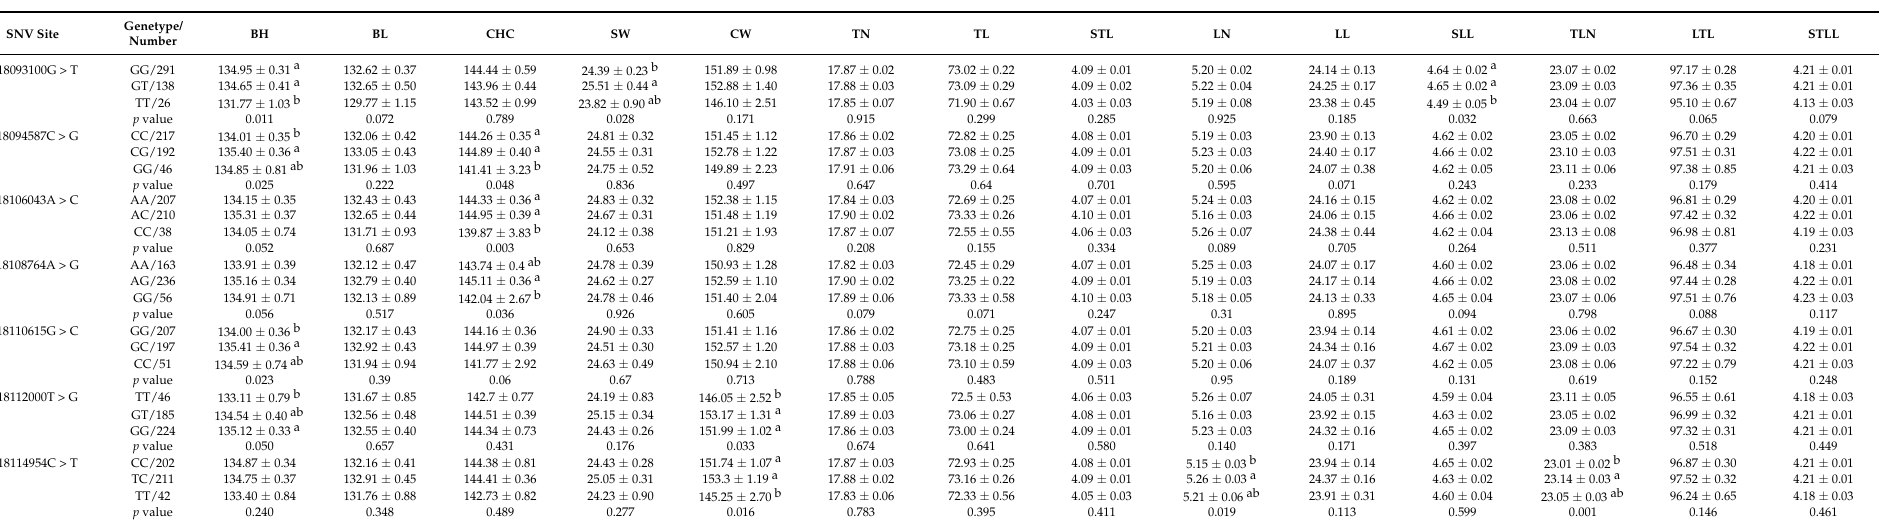
Table 4. Multiple comparisons between genotypes of seven SNVs and body size traits, slaughter traits and thoracolumbar character in Dezhou